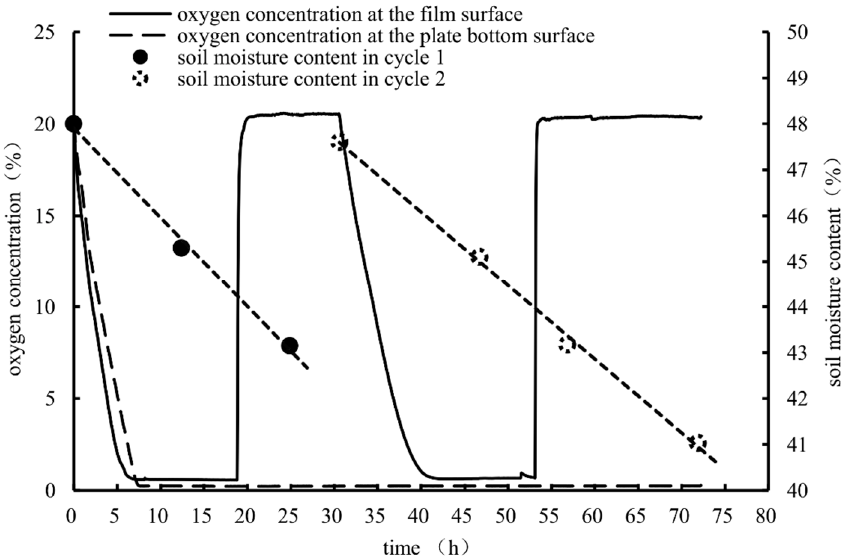
Figure 6. Changes in oxygen concentration and soil moisture content with time.